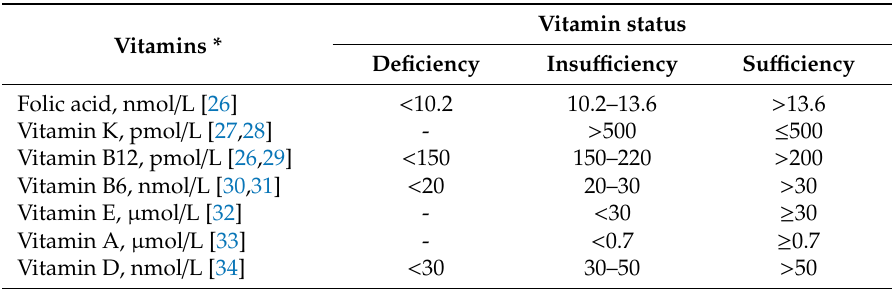
Table 1. Vitamin cuto ff